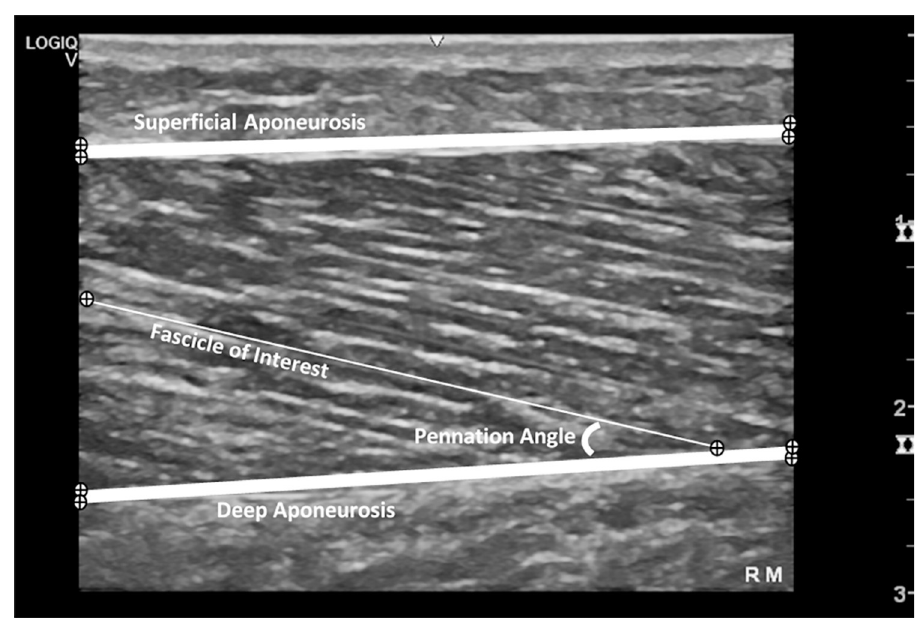
Fig 2. Ultrasound image from a right medial head of gastrocnemius of a participant, showing an example of the points plotted ( � ) for superficial aponeurosis borders, deep aponeurosis borders, and a selected fascicle length and corresponding pennation angle.